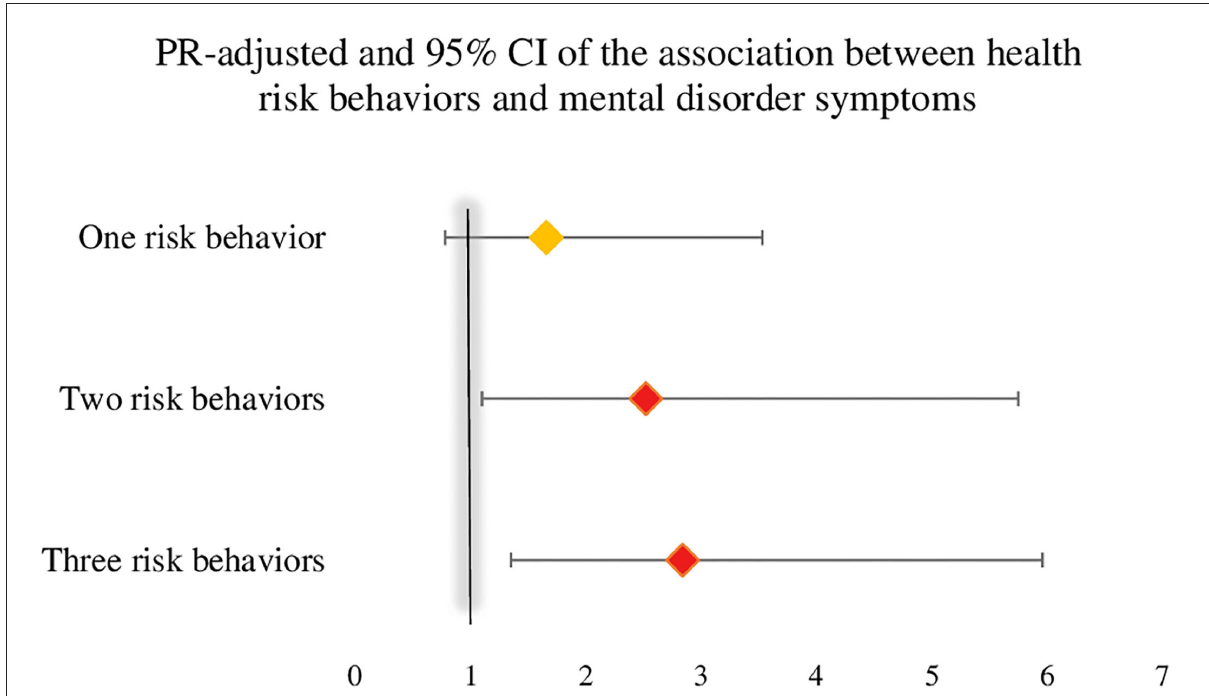
FIGURE5 Prevalence ratio and 95% CI for the association between the co-occurrence health risk behaviors and the presence of symptoms of mental disorder, COVID Inconfidentes 2020. Poisson regression analysis to verify the existence of an association between the outcome (presence of depression or anxiety symptom) and the explanatory variables, given as health risk behaviors sedentary behavior, non-daily consumption of fruits and vegetables, and high weekly consumption of ultra-processed foods. The analysis was adjusted for sex, age, family income, having a job, and